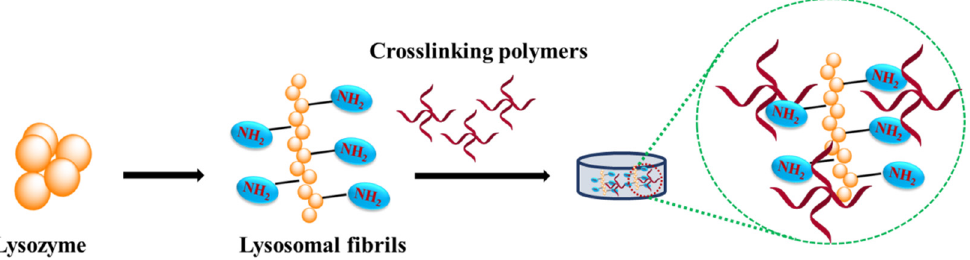
Figure 5. Approach towards lysozyme crosslinking for hydrogel formation.